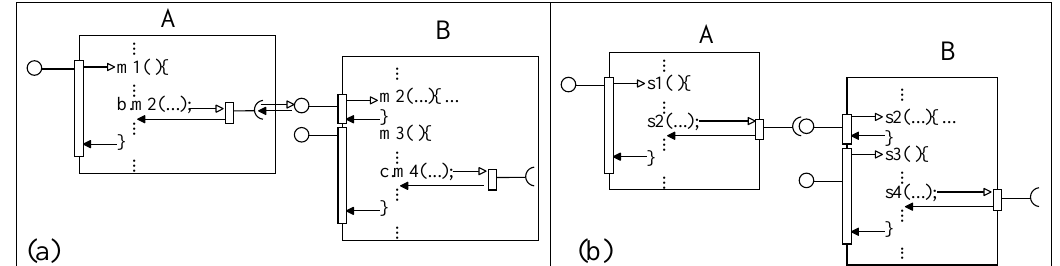
Figure 25. Behavior of Components: ( a ) First view, and ( b ) Second